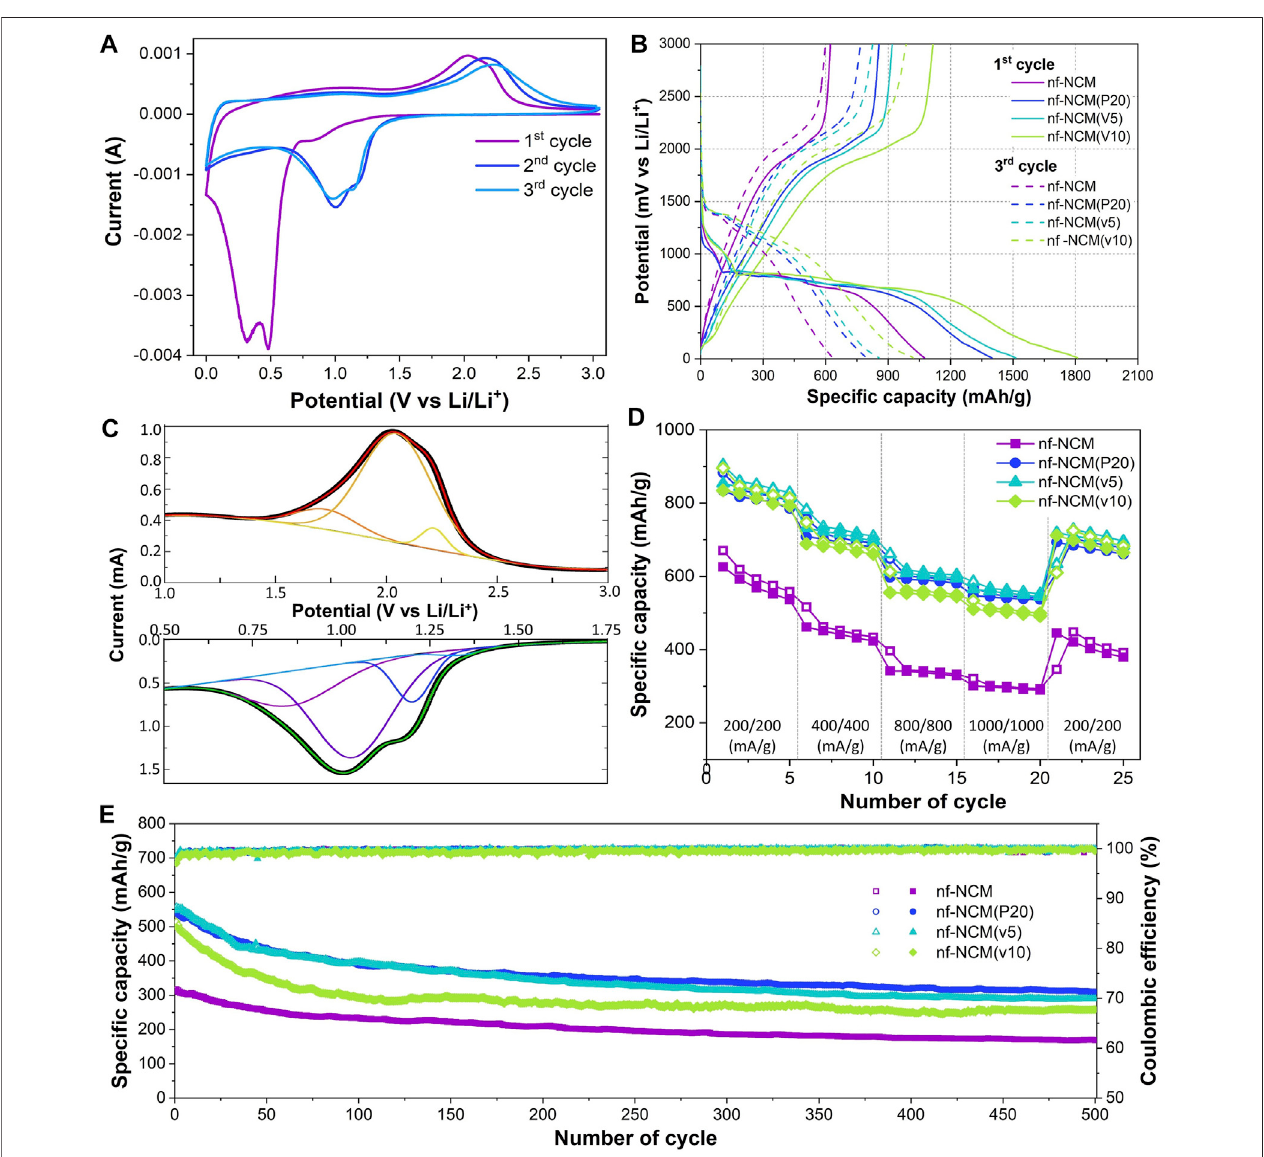
FIGURE3|(A) Cyclic-voltammetrycurvefornf-NCM. (B) Capacityversusvoltagepro fi leofallfoursamples. (C) Deconvolutedpeaksfromthecathodicandanodic peaks of the CV curve shown in Figure 3A. (D) Rate capability pro fi le of all samples. (E) Capacity retention of all samples after 500 cycles of charge – discharge at 1,000 mA g − 1